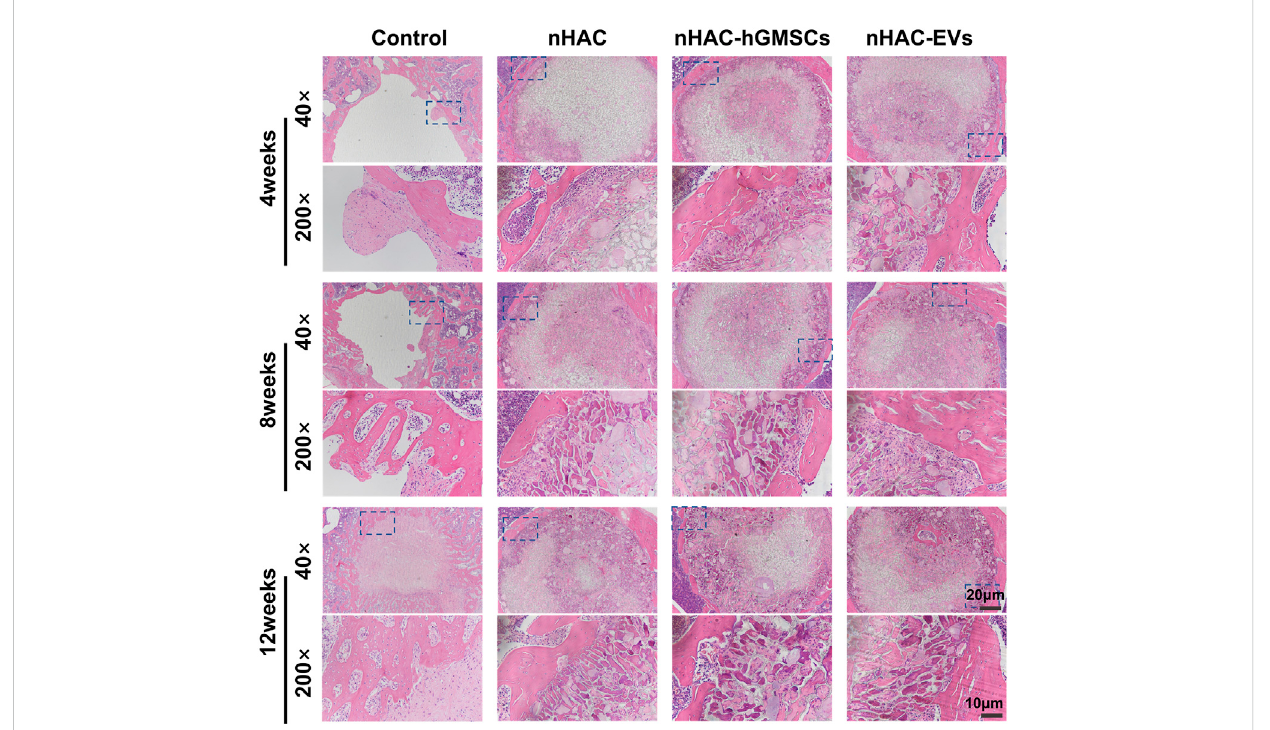
FIGURE 6 Representative images of HE staining of the bone defect area. The 200× image is an enlargement in the dashed box of the 40× image.